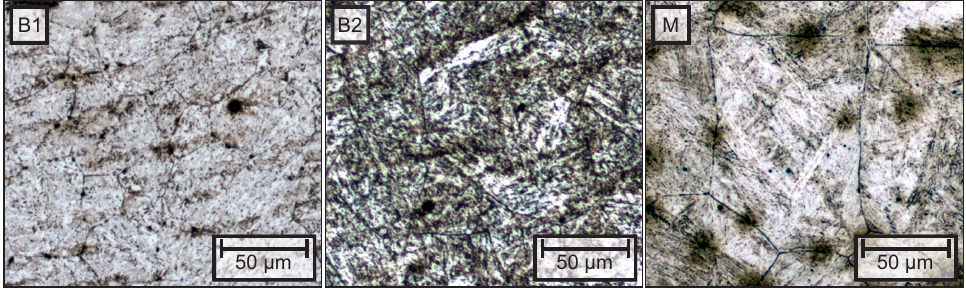
Figure 6. Prior austenite grains of the investigated bainitic (B1 and B2) and martensitic (M) steel, revealed by picric etching.